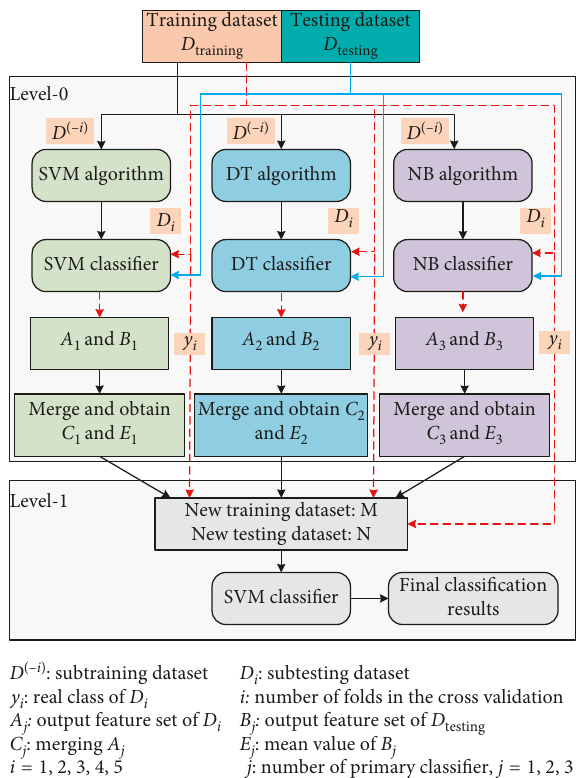
Figure 1: The description of the SG ensemble